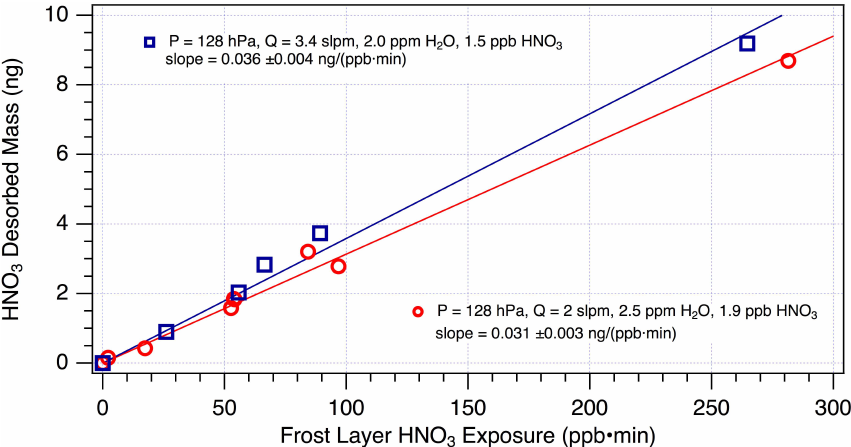
Fig. 5. Mass of HNO 3 measured during mirror frost layer evaporation events plotted against the frost layer exposure to HNO 3 expressed as the time integrated mixing ratio. The legend shows the experimental conditions of pressure, sample flow ( Q ), and water vapour and HNO 3 mixing ratios, along with the derived growth rate from the best fit line with a zero